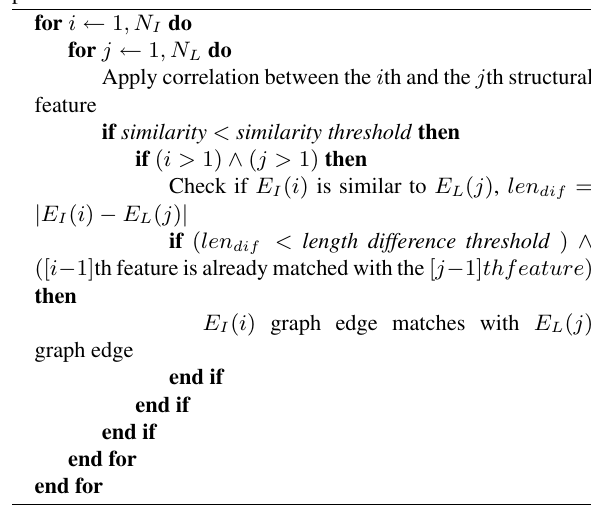
Algorithm 1 Matching the iPhone image features to the projected point cloud